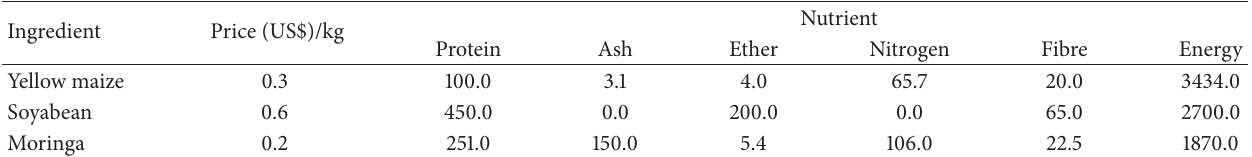
Table 4: Maximum nutrients content available in the ingredient.